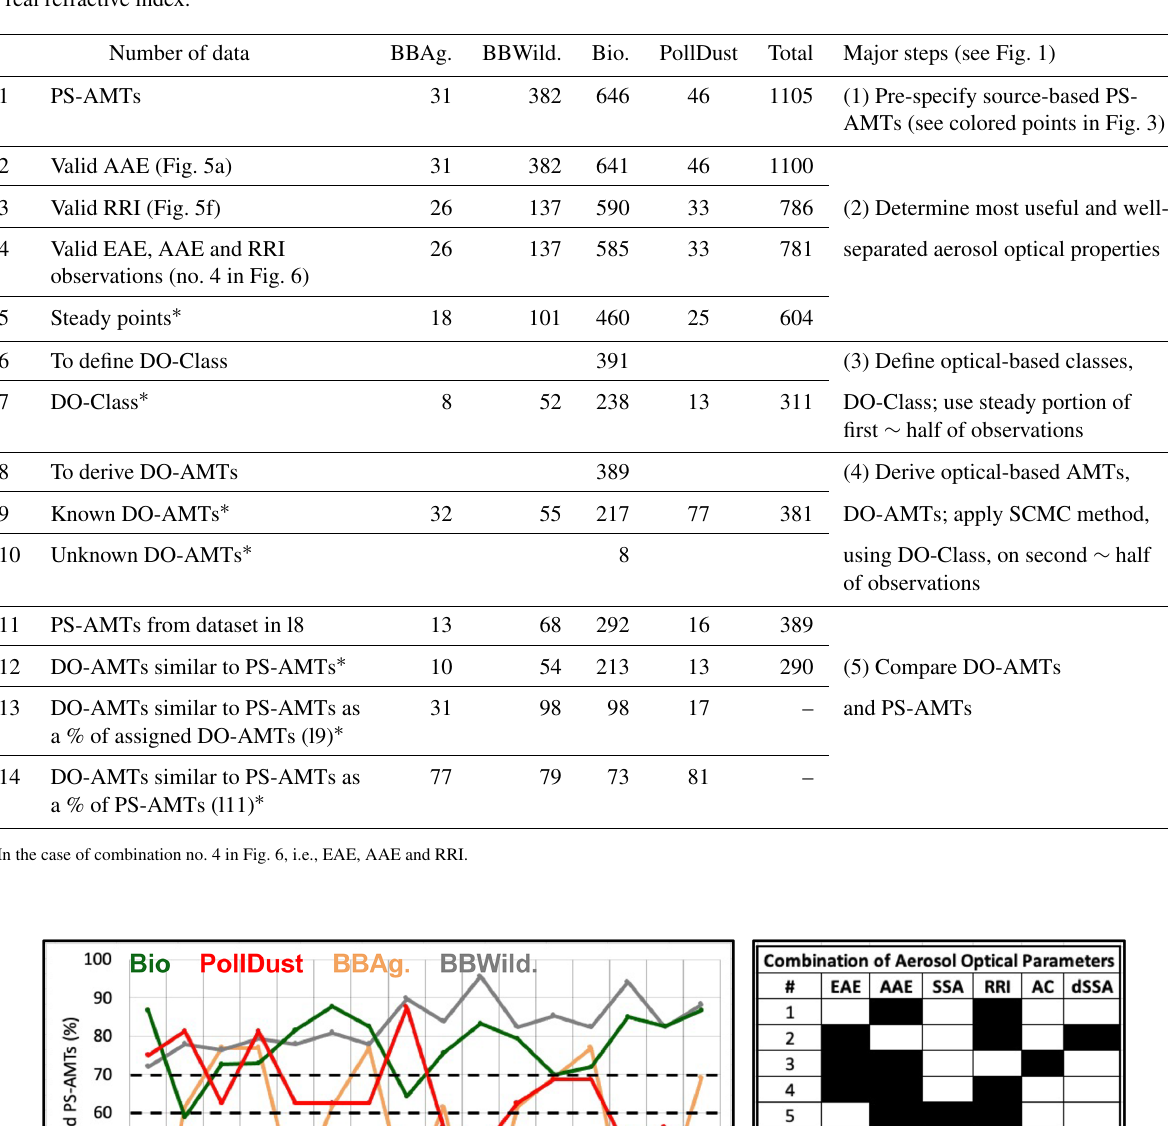
Table 3. Number of data points per AMT behind each step in our study. PS-AMTs marine and urban are not analyzed due to their limited number of data points ( N = 9 urban and N = 7 marine PS-AMTs). EAE: extinction Ångström exponent; AAE: aerosol absorption exponent;